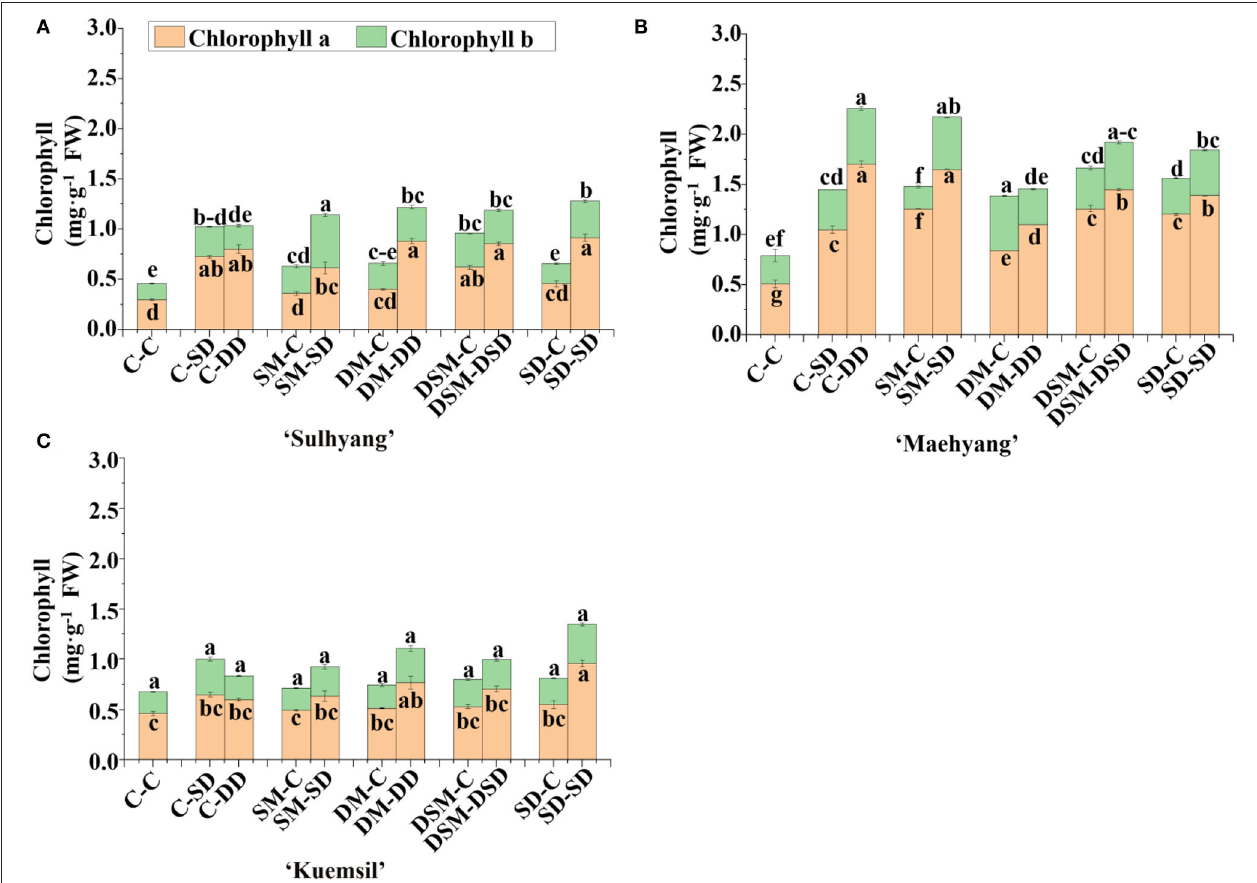
FIGURE 5 | Chlorophyll content of strawberry transplants (A) “Sulhyang”; (B) “Maehyang”; and (C) “Kuemsil” as affected by Si treatment after subjection to 43 ◦ C for 7 days. Lowercase letters indicate significant differences calculated by the Duncan’s multiple range test at p ≤ 0.05. See Figure 1 for descriptions of treatment